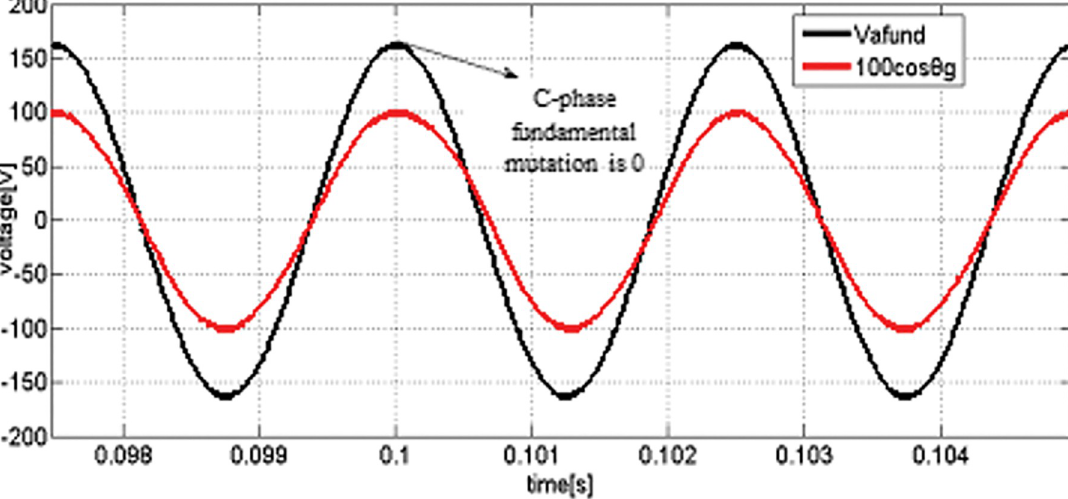
Fig 11. Simulation results of cos θ g under unbalanced grid